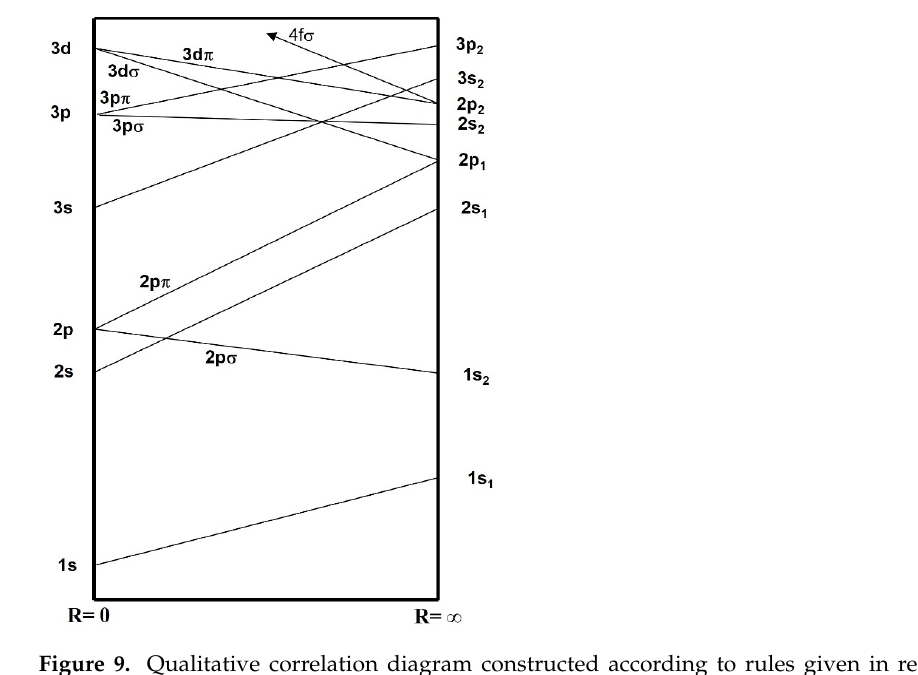
Figure 9. Qualitative correlation diagram constructed according to rules given in ref. [14], for colli- sions between two atoms of atomic number Z 1 and Z 2 , with Z 1 slightly larger than Z 2 .